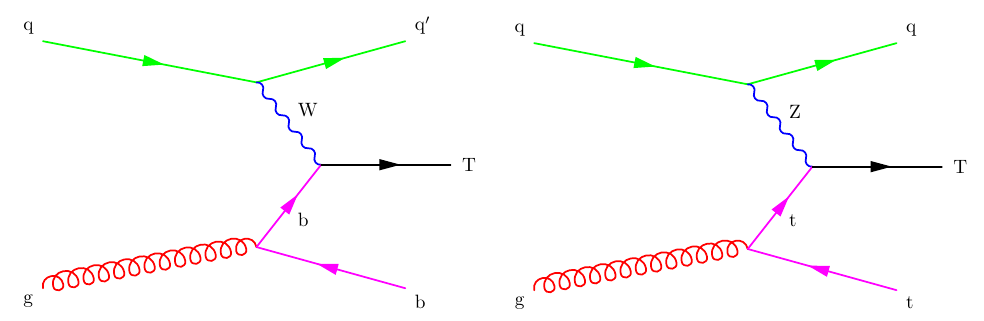
Figure 1 . Example production diagrams for the processes pp ! Tbq via the charged current (left) and pp ! Ttq via the neutral current